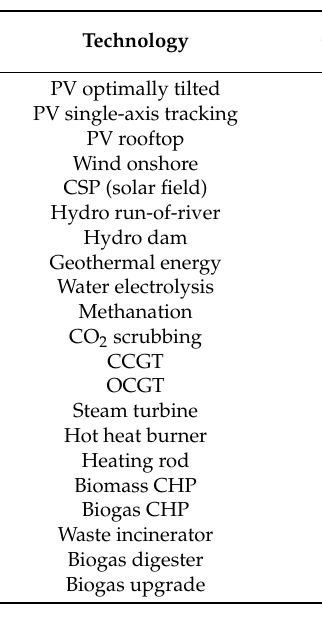
Table 2. Financial assumptions for major energy system